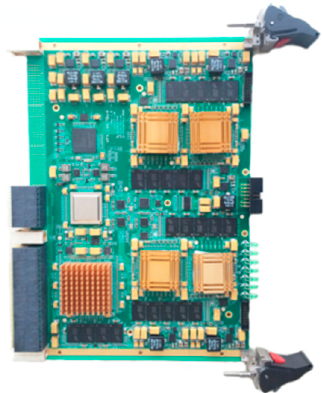
Figure 14. The digital signal platform. Figure 15. The digital signal platform.